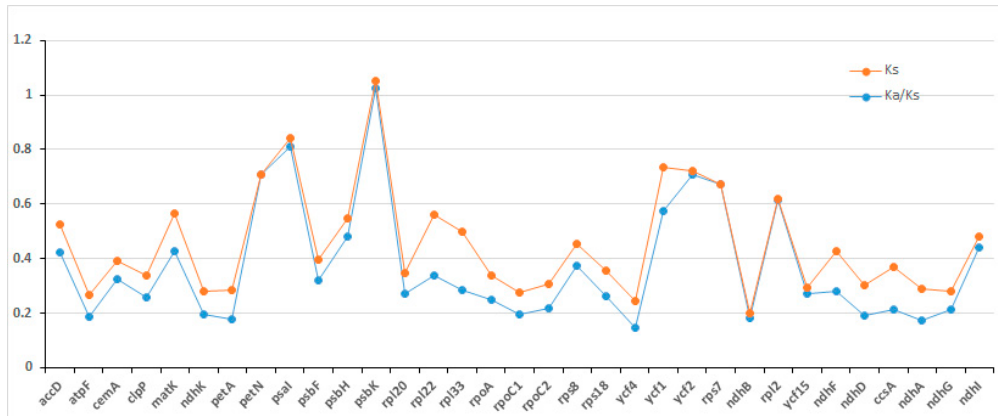
Figure 3. Non-synonymous (Ka) and synonymous (Ks) substitution rates and Ka/Ks ratio between I. pinfanensis and H. triflora . One gene psbK had Ka/Ks ratio greater than 1.0, whereas all the other genes were less than